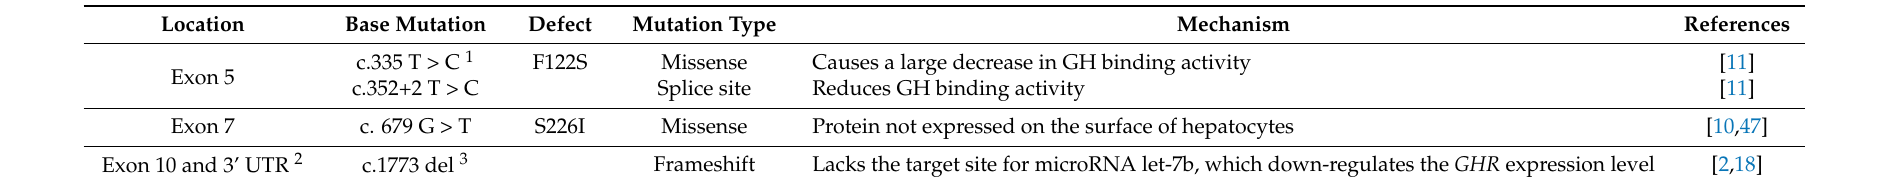
Table 3. Mutations in GHR relevant to sex-linked dwarfism (SLD) in